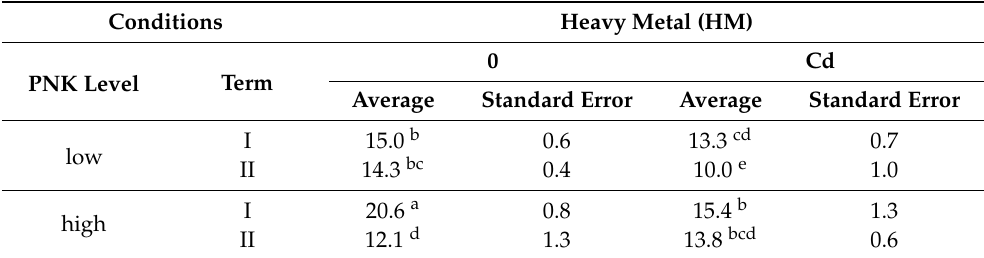
Table 6. The numer of Hydrocharis morsus-ranae rosette in the three tested growing seasons.